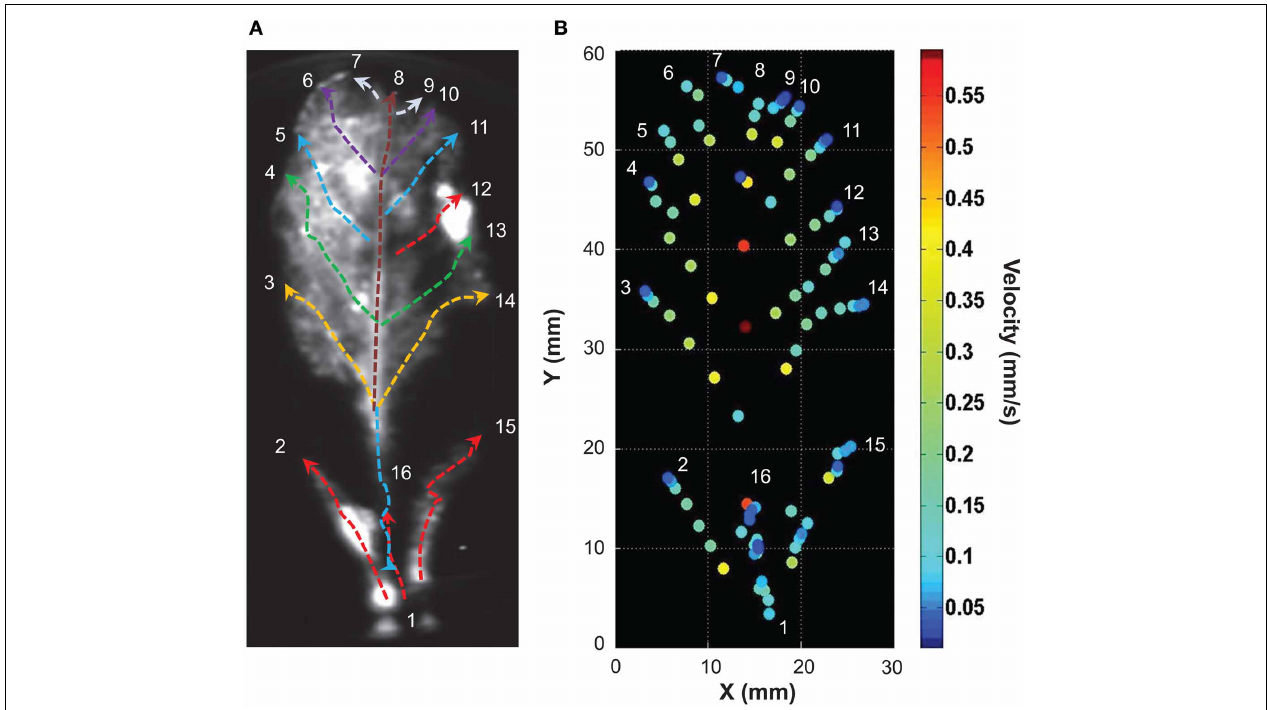
duration and latency are presented on Table 2 ; colors of dashed arrows refer to the latency values so that Ca 2 + waves that started at similar times are in the same color). (B) Propagation speeds along the main leaf vein are indicated for selected points (same space scale as in A ). False color scale is in mm/s.